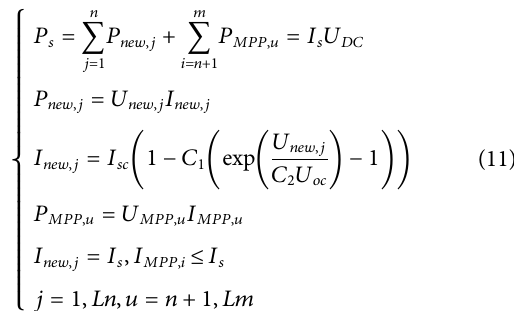
b. Adjusting the working points of normal PV panels slightly below their MPP points and the shaded PV panels are controlled in the MPPT mode.